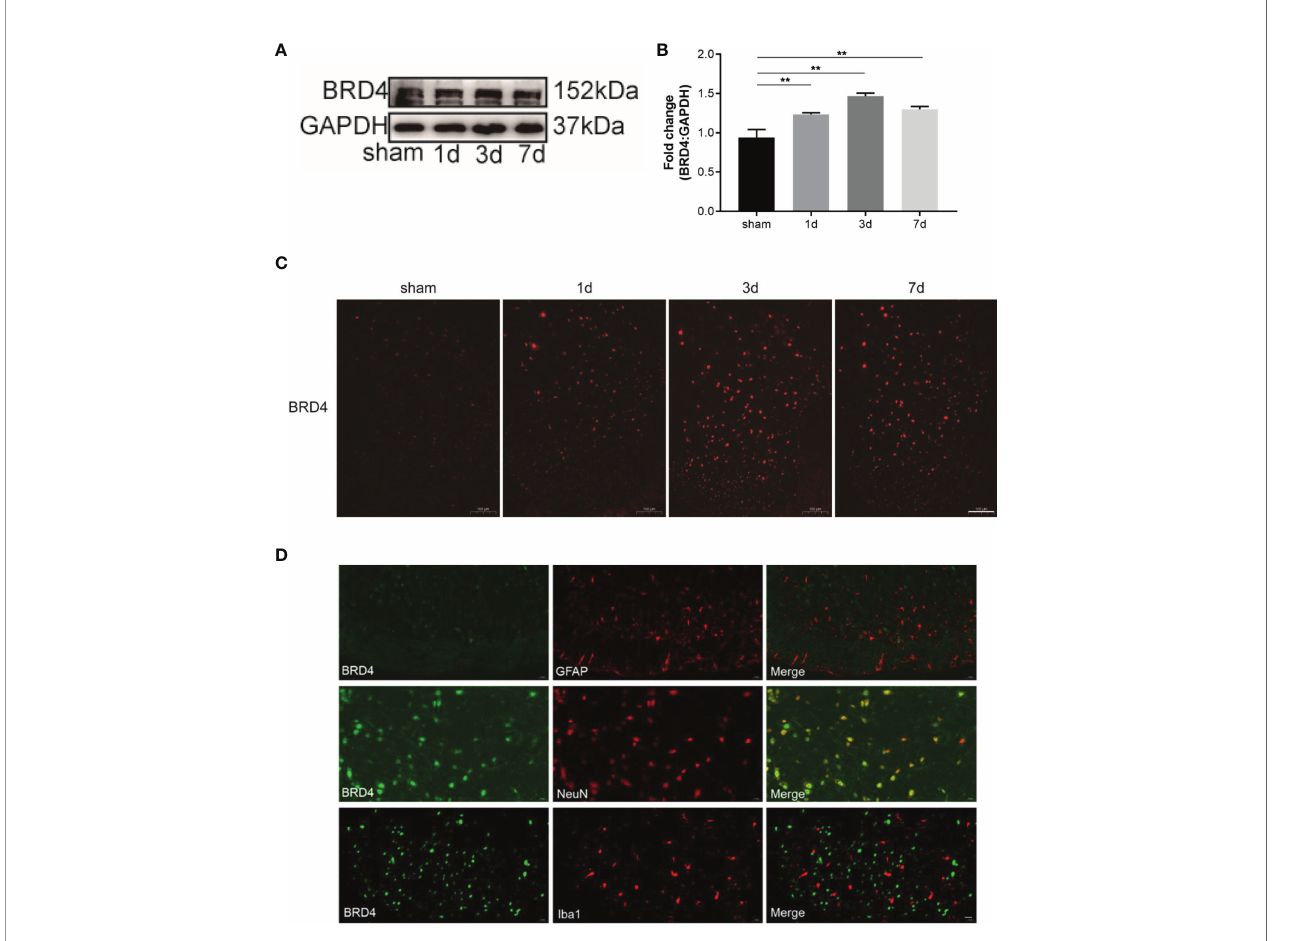
FIGURE 1 | BRD4 expression is increased during complete Freund ’ s adjuvant (CFA)-induced in fl ammatory pain. (A) BRD4 expression levels in the dorsal horn of the spinal cords were tested by using western blot on days 1, 3, and 7. (B) Subsequent quantitative analysis of BRD4 expression. (C) BRD4 expression was also re fl ected by Immuno fl uorescence intensity in the dorsal horn of the spinal cord at different groups. Bar=100 µm (D) . Double immuno fl uorescence staining of BRD4 with microglia marker iba1 or astrocyte marker GFAP, neuron marker NeuN. Bar=20 µm. Data were presented as mean ± standard deviation (SD), n=4 mice/group. (**P <